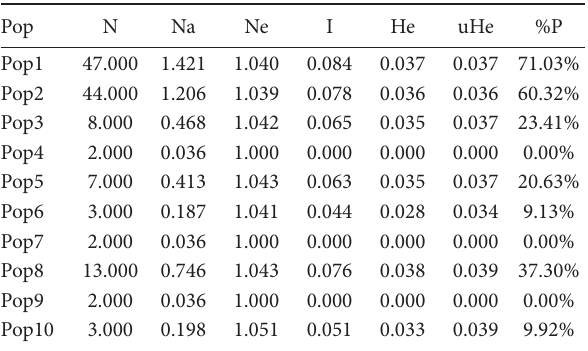
Table 2. Genetic diversity parameters determined in geographical populations with rice genotypes.